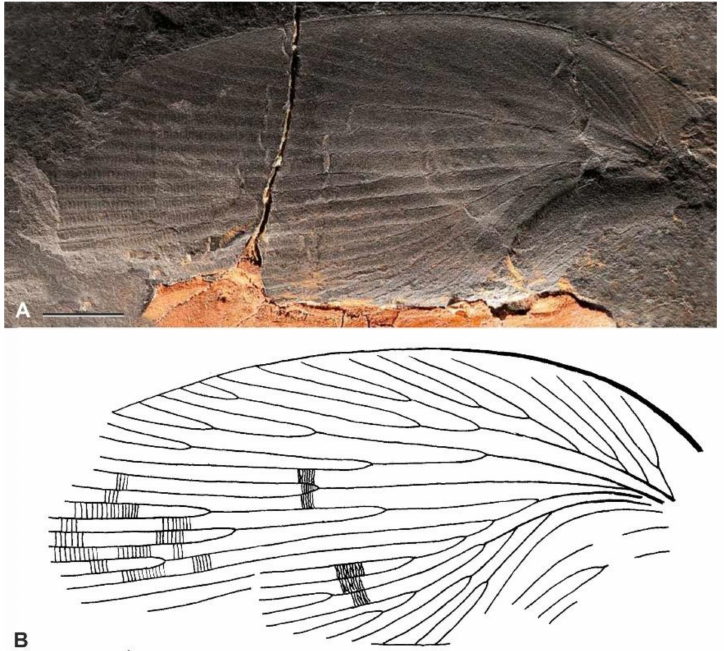
Figure 6. ( A , B )— Progonoblattina clarkii (Scudder, 1893): type specimen of Etoblattina clarkii Scudder,